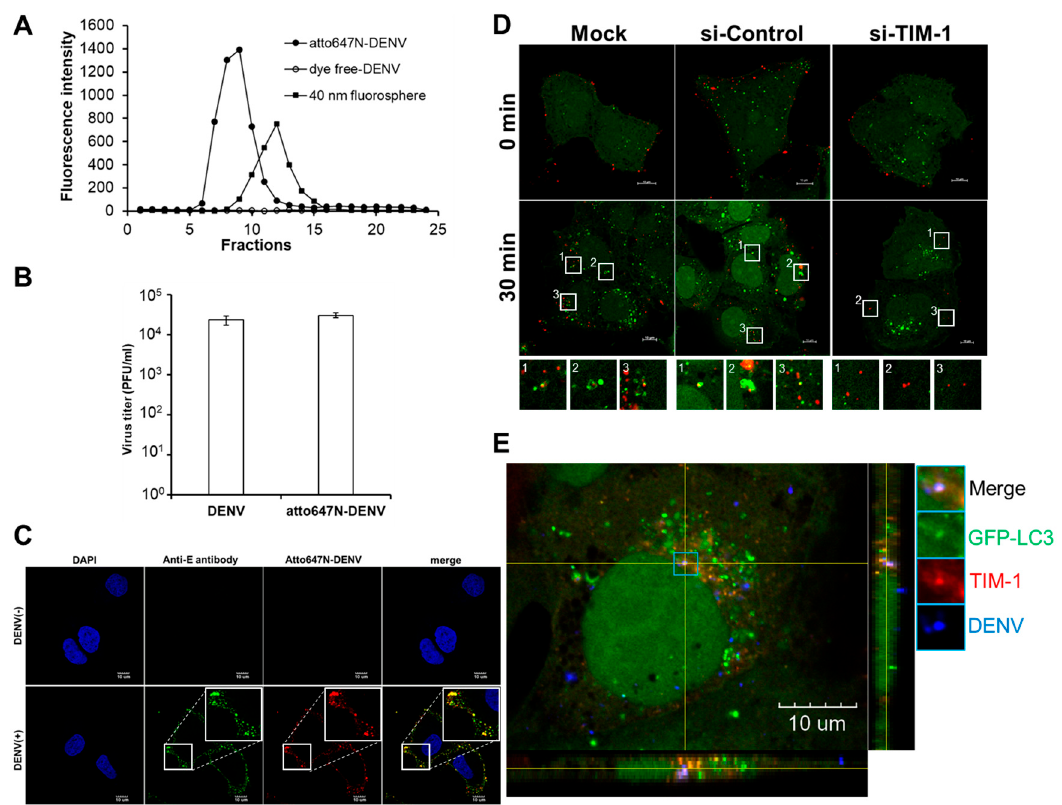
Figure 3. Colocalization of TIM-1 with DENV particles and autophagosomes. ( A ) The fluorescence intensity profiles of elution from a Sephadex G-25 size-exclusion column was displayed. Atto647N-labeled DENV particle was purified within the fraction layer 7 to 11 from gel filtration (solid circle). No fluorescence signal was detected in Atto647N-free DENV (open circles) within the same fraction layers. The 40 nm fluorescence microspheres were used as a size marker (solid square). ( B ) Plaque assays were performed to determine the infectivity of DENV particles incubated with Atto647N. Atto647N-free DENV (DENV) was used as a control. Virus particles were purified from the same fractions of the Sephadex G-50 column. The results were determined by at least three independent experiments. ( C ) Atto647N-DENV particles were visualized by an anti-E antibody. Atto647N-DENV (MOI of 20) attached to the surface of Huh7.5 cells at 4°C for 30 min were recognized by an anti-E antibody. The insets showed the localization of Atto647N-DENV signals coincides with DENV E protein. The scale bar represents 10 μ m. ( D ) The formation of autophagosomes (green) and the distribution of Atto647N-DENV particles (red) were displayed by confocal imaging (Olympus FluoView 1000). GFP-LC3-Huh7.5 cells were treated either with si-control or si-TIM-1 prior to DENV infection at a MOI of 10. The confocal images were acquired by the Olympus FluoView 1000 confocal microscopy at 0 and 30 min post-infection, respectively. The insets showed no colocalization of Atto647N-DENV signals with LC3 puncta in si-TIM-1-treated cells. The scale bar represents 10 μ m. ( E ) The three-dimensional reconstruction of the Z-stacked deconvolved image showed the co-localization of TIM-1 (red) with DENV particles (blue) on an autophagosome (green) in a GFP-LC3-Huh7.5 cell one hour post-infection. The scale bar represents 10 μ m.